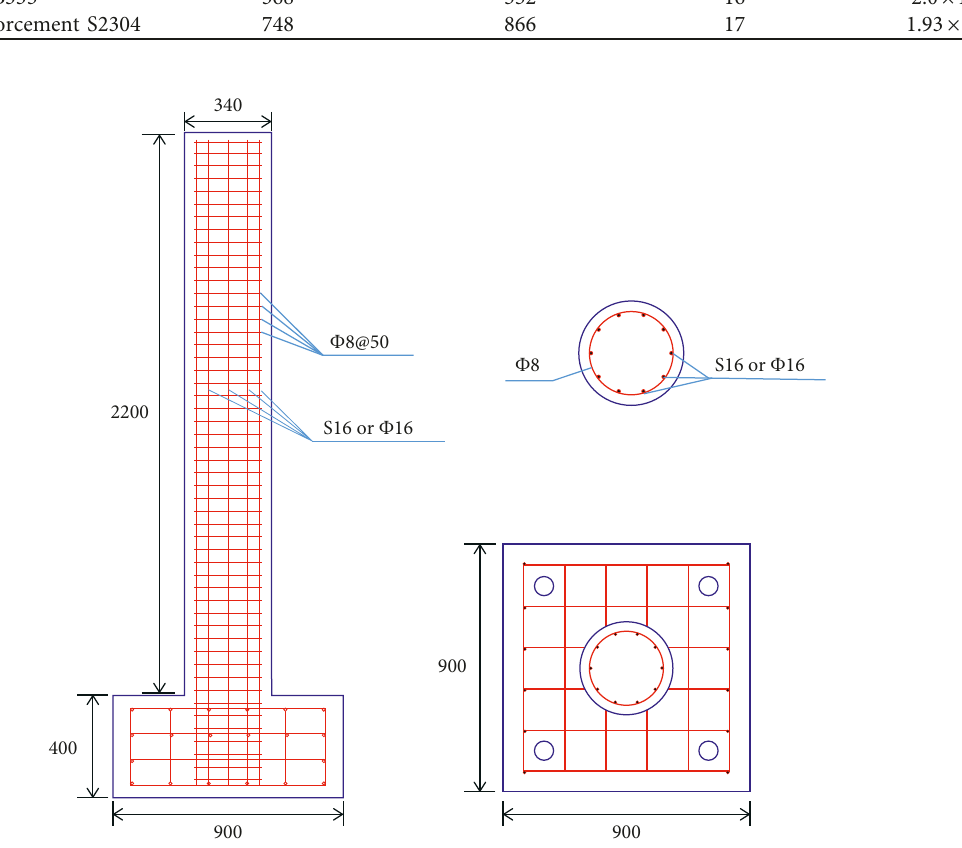
Figure 1: Detail drawing of reinforced concrete (unit: